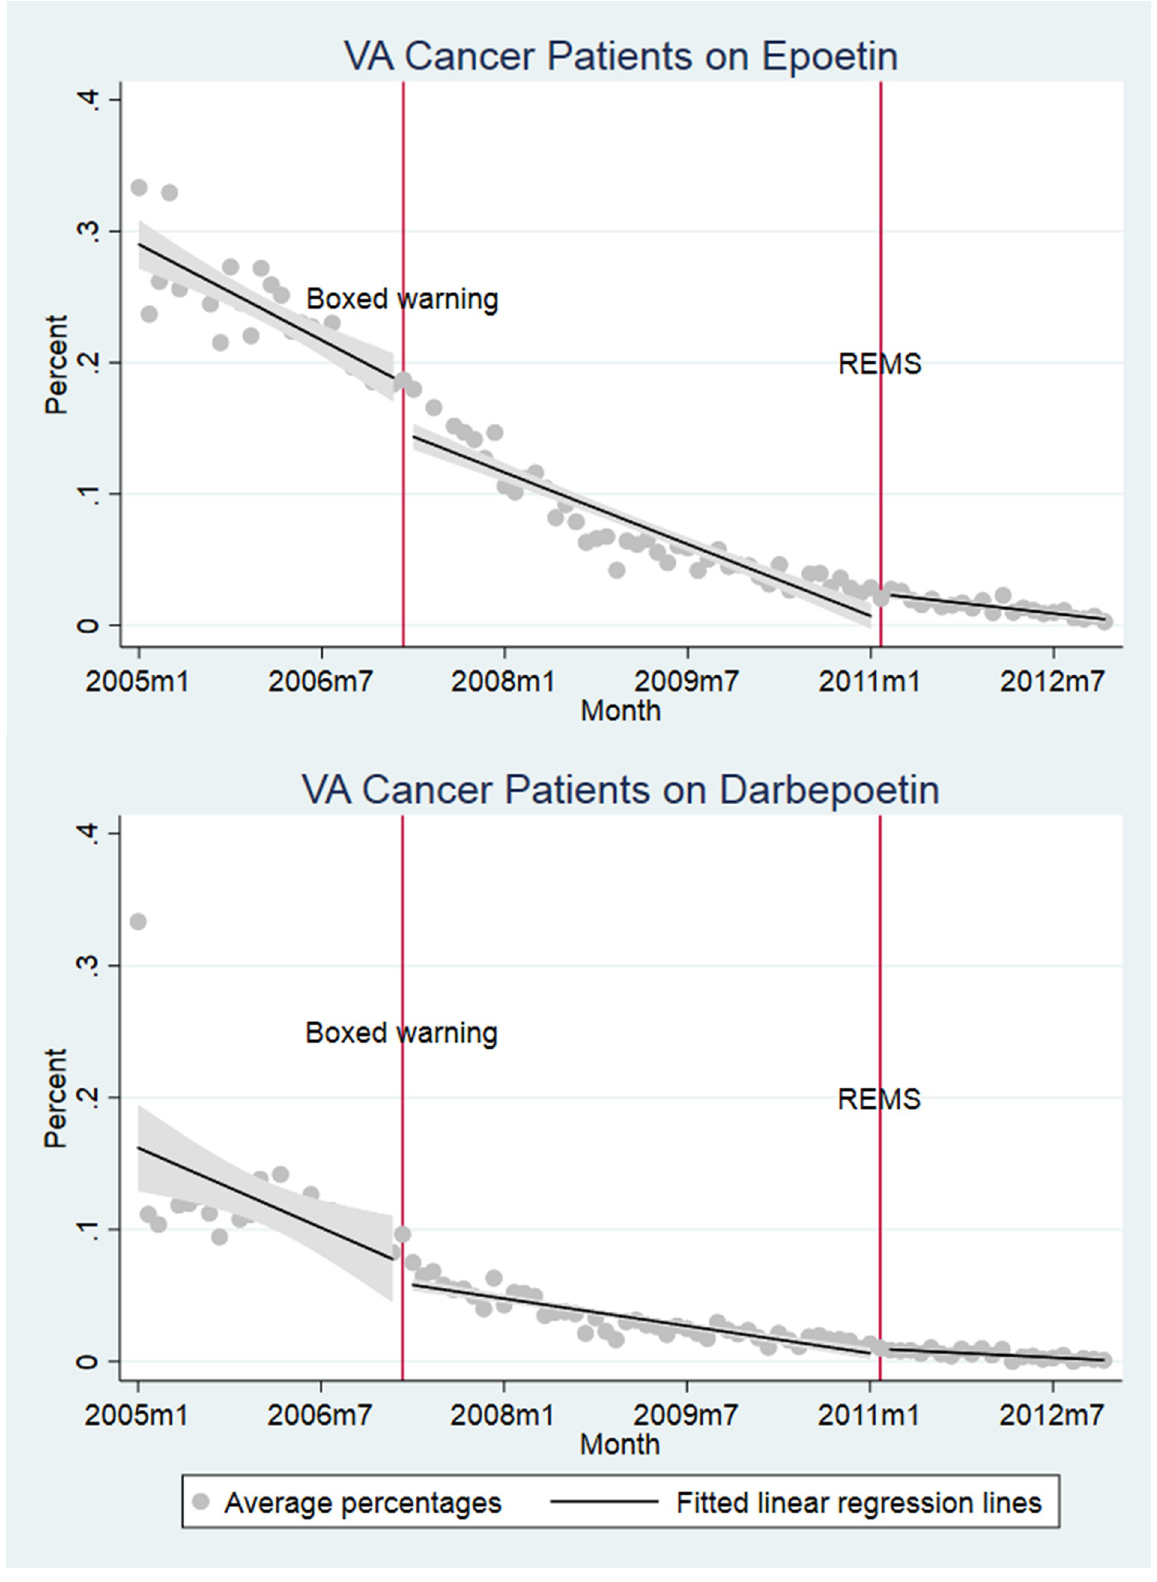
Fig 1. (a) VA cancer patients on epoetin and (b) VA Cancer patients on darbepoetin. https://doi.org/10.1371/journal.pone.0234541.g001 PLOS ONE | https://doi.org/10.1371/journal.pone.0234541 June 25,